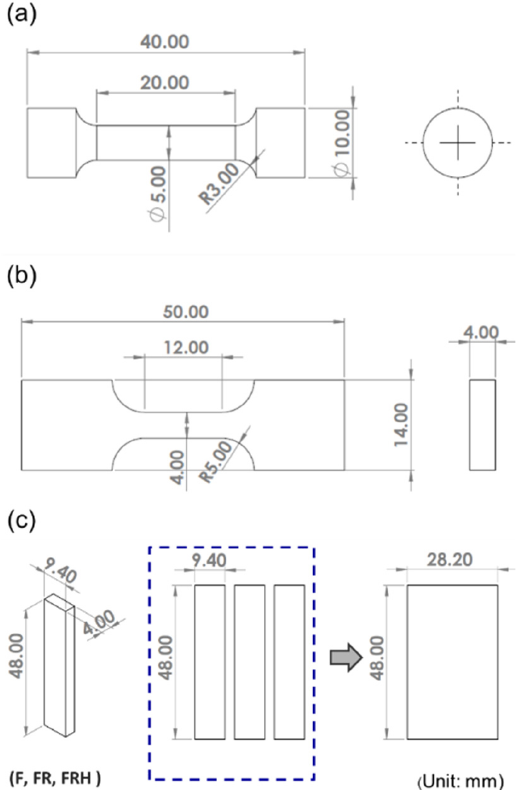
Figure 2. Specifications of the tensile specimens: ( a ) group F, ( b ) groups FR and FRH, and ( c ) specimens for erosion wear (a flow chart of three pieces combined into one piece).